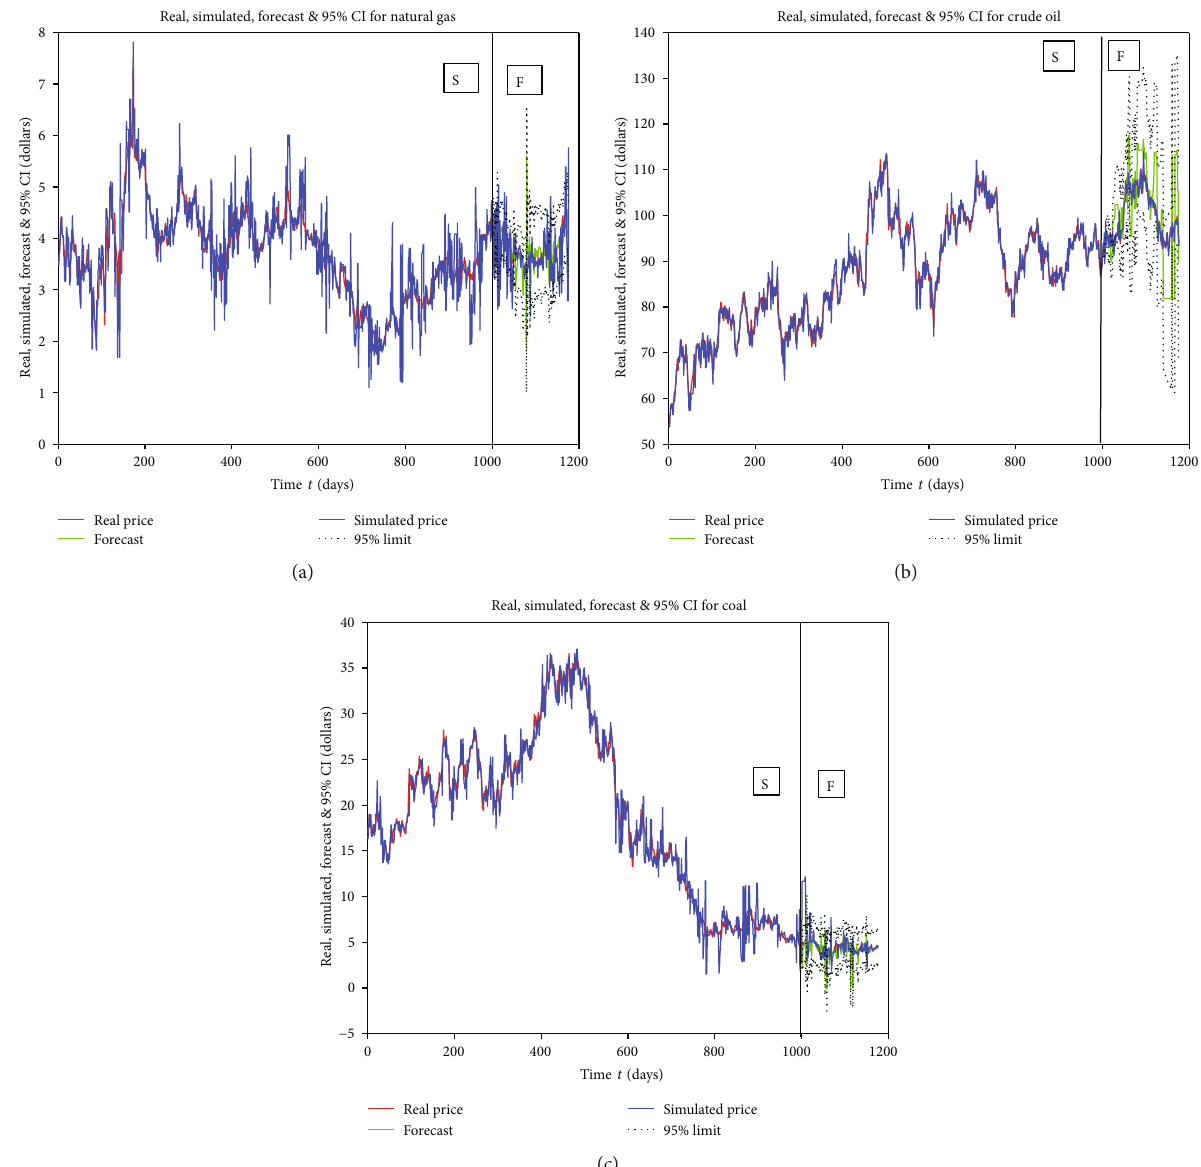
Figure 15: Real, simulated, forecasted prices and 95% C.I. with no